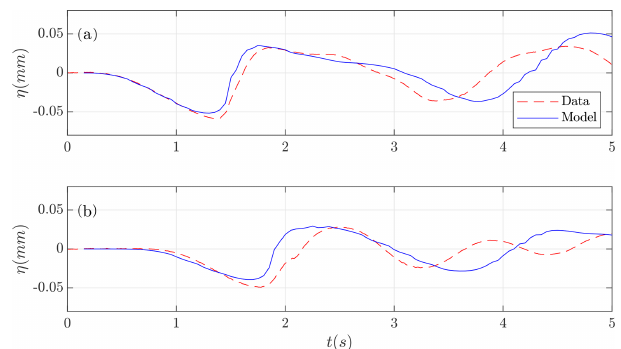
Figure 15. Submerged test case. Lab-measured run-up (red) and numerical time series (blue) at run-up gauges (a) RG2 and (b)